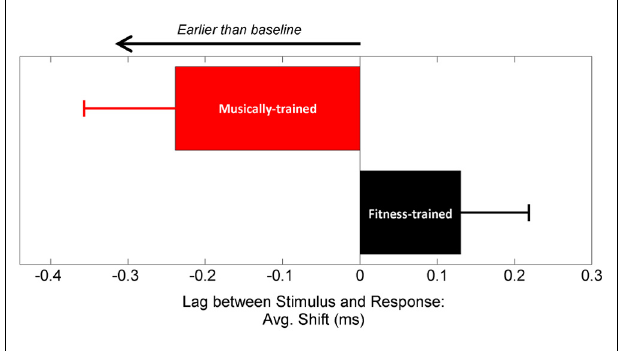
FIGURE 2 | In-school music training increases neural resilience to the effects of noise. After 2 years, the stimulus-to-response lag was earlier for the musically trained group (red) while the fitness-trained group (black) did not change from pre-test. Stimulus-to-response lag was computed automatically using a cross-correlation algorithm. Error bars represent ± 1 standard error of the